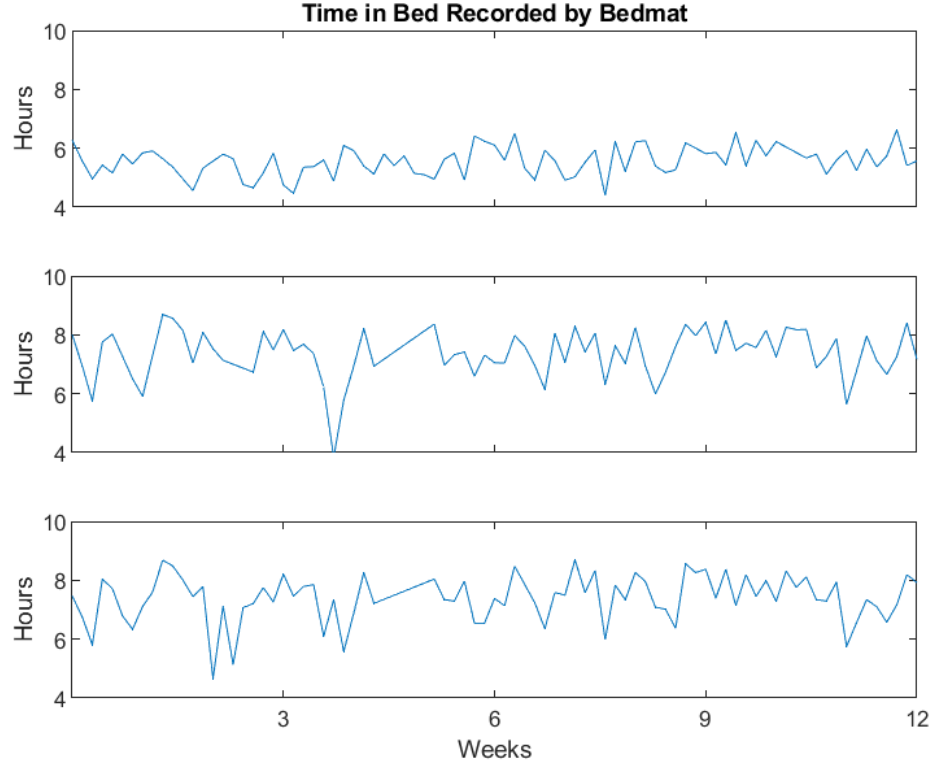
Figure 2. Nightly total time in bed for three representative participants using the Emfit bed mat.